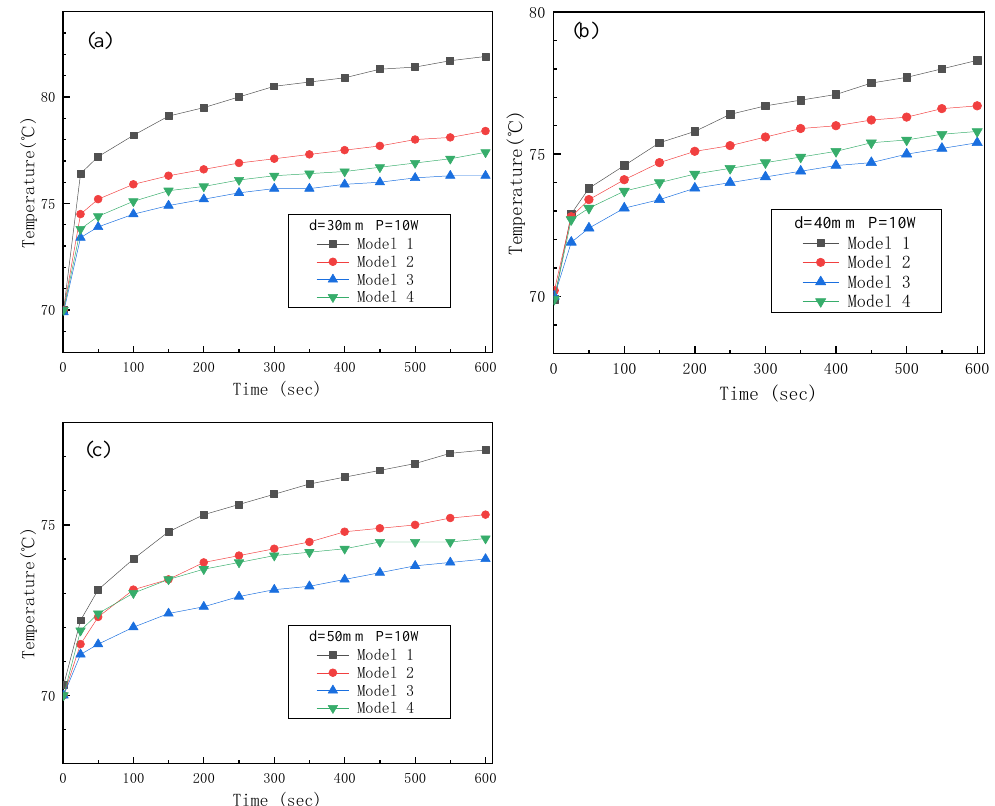
Figure 6. Performance of each module under 10 W with heat source size S = ( a ) 30 mm × 30 mm, ( b ) 40 mm × 40 mm, and ( c ) 50 mm × 50 mm.